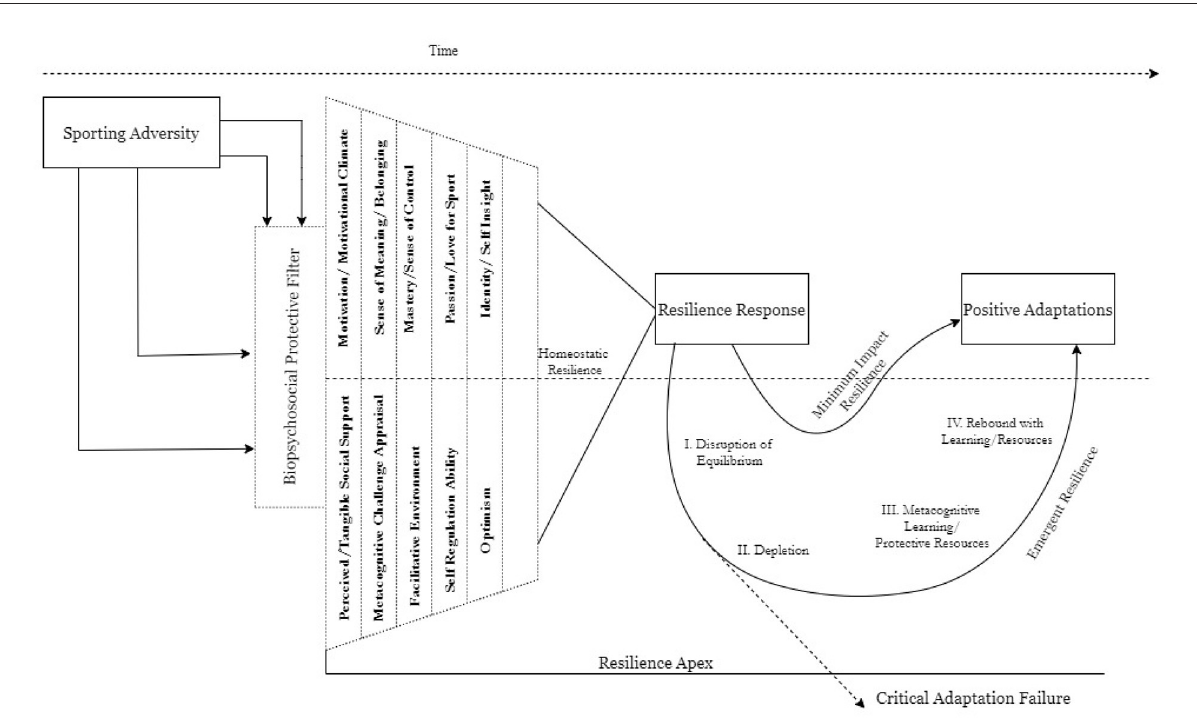
FIGURE3 Sporting resilience meta-model. The adversity experience passes through the individual’s biopsychosocial protective filter. Depending on the strength of the resources available in this protective filter, the impact of the adversity initiates a specific trajectory of resilience response. Response Trajectory A- causes a minimum disruption due to low intensity adversity and/or a strong protective filter causes quicker resilience adaptation. Trajectory B- undergoes through four levels of Disruption of Equilibrium, Disruption, Metacognitive Appraisal and Rebound during the course of resilience